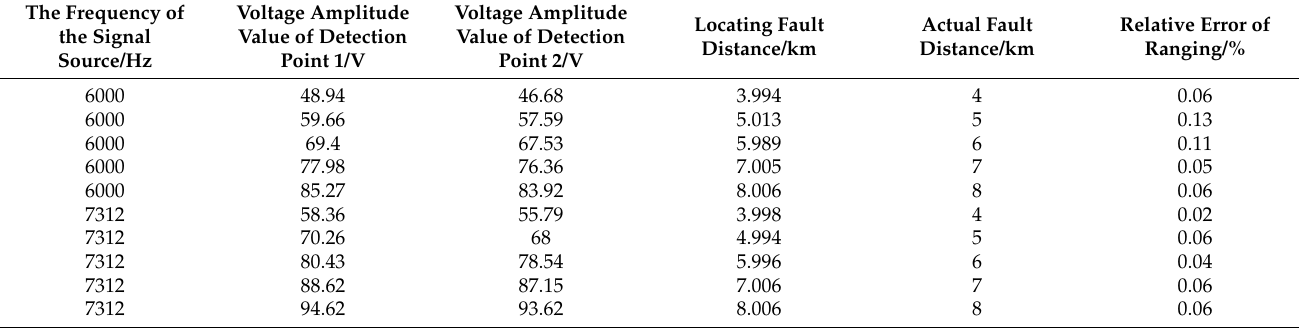
Table 1. Analysis of fault location